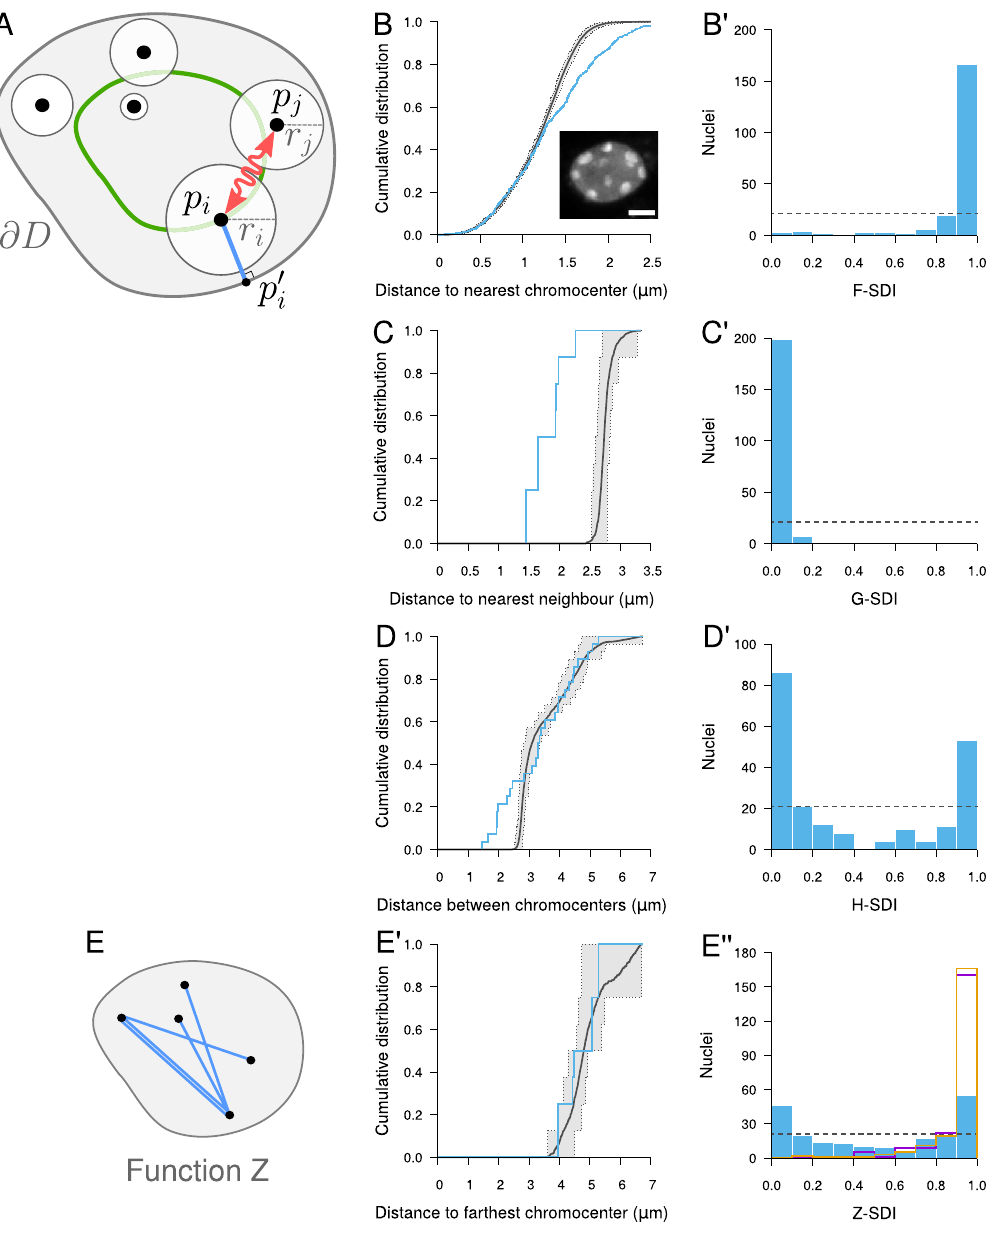
Figure 5. Orbital maximal repulsion model of object distribution and its application to the distribution of chromocenters in A. thaliana cell nuclei. ( A ) Orbital maximal repulsion model: objects are positioned as far as possible from their nearest neighbor while moving over their respective orbits. ( B ) Measured ( Blue ) and model ( Black ) functions F in a sample nucleus ( Inset ; scale bar: 2 µ m). Dotted lines : lower and upper limit of the 95% envelope ( Grey ) under the model. ( B ′ ) Distribution of the F -SDI in the population of nuclei. Dotted line : distribution expected under the orbital maximal repulsion model. ( C , D ) Same as ( B ) for functions G and H . ( C ′ , D ′ ) Same as ( B ′ ) with the G and H -SDIs. ( E ) Distance measurements used to compute function Z . ( E ′ , E” ) Same as ( B , B ′ ) for function Z . Magenta and Orange : Z -SDI histograms for the completely random and orbital models,